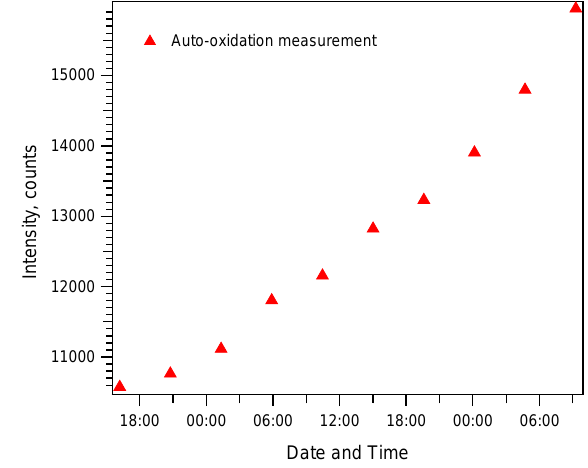
Fig. 7. Auto-oxidation (pure water blank) measurements of DCFH over time, demonstrating the drift of the DCFH working solution during regular operation of the online